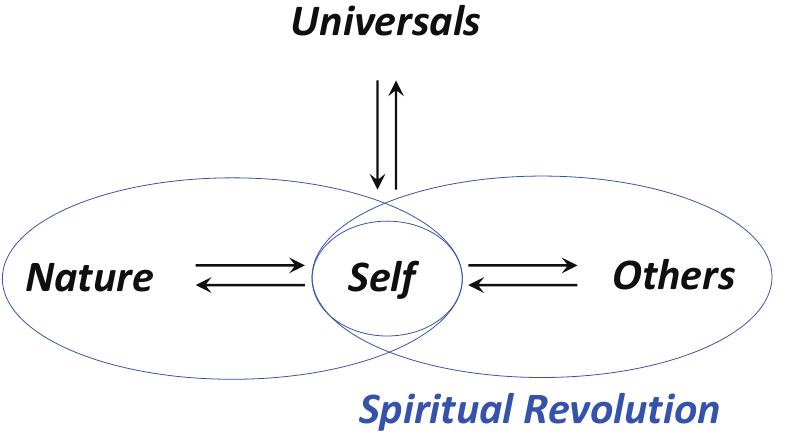
Figure 1. A schematic diagram, drawn based on Ito [1–4], of the structure of Spiritual Revolution, which shows that the self and others can coexist through universals as